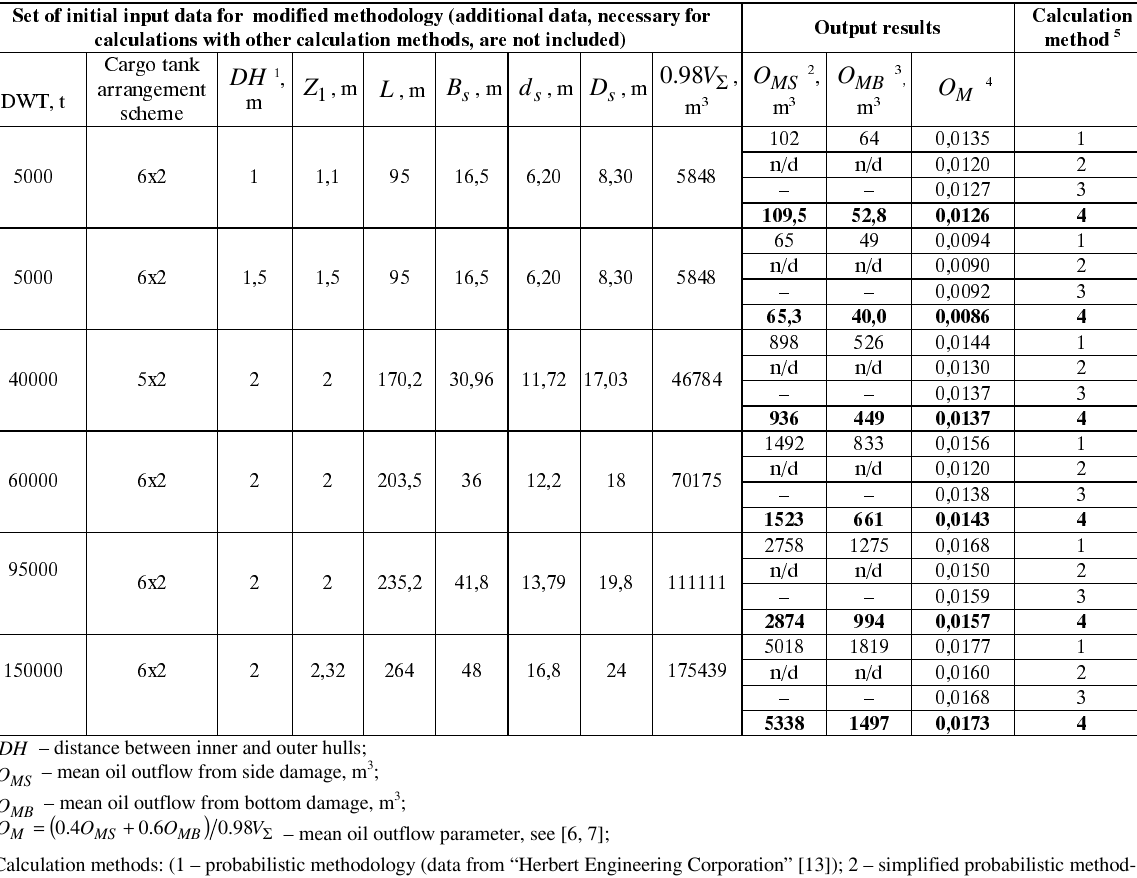
Fig 4. Application scheme of modified methodology and peculiarities Table 4. Oil outflow parameters estimated by different methodologies for some tankers Set of initial input data for modified methodology (additional data, necessary for calculations with other calculation methods, are not